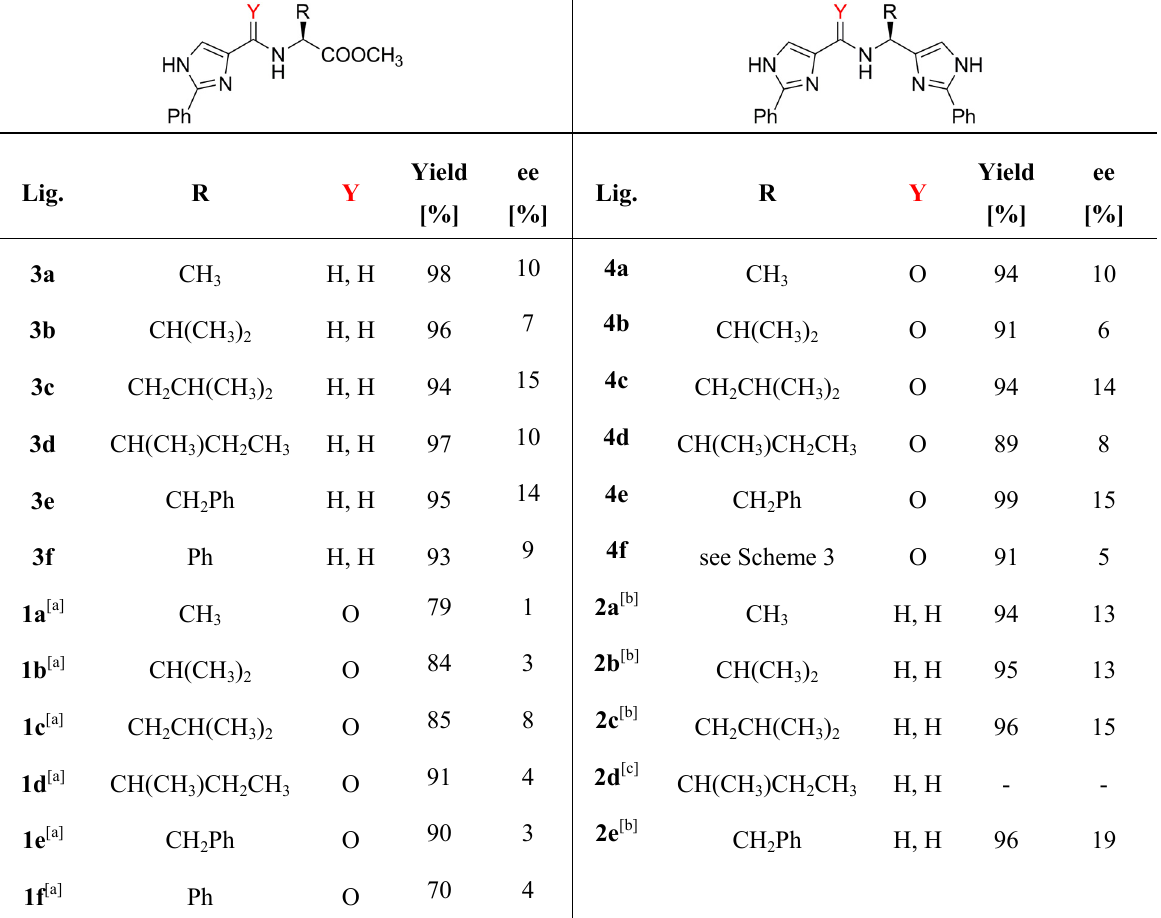
Table 3. The Henry reaction – yields and enantiomeric